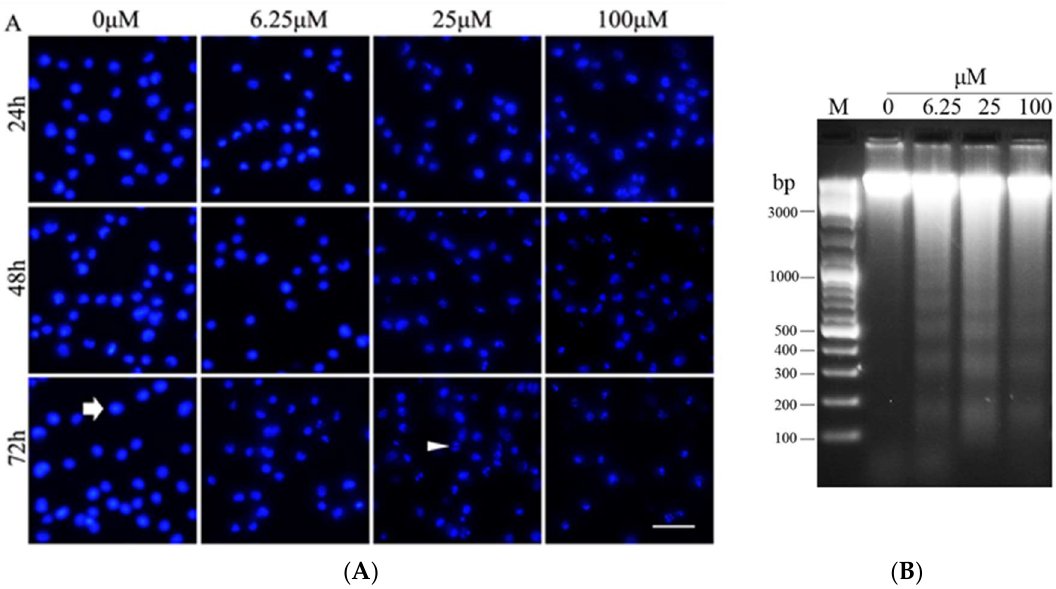
Figure 6. Effects of luteoloside on nuclear morphology and DNA fragmentation in Hela cells. ( A ) The cells treated with or without luteoloside were stained with Hoechst 33342 and observed under a fluorescence microscope. The arrow indicates the cells with round and intact nuclei. The arrowhead indicates the cells with the typical characteristics of apoptosis. Bar = 25 μm; ( B ) Total genomic DNA was isolated from Hela cells treated with or without luteoloside for 48 h. DNA fragmentation was analyzed by agarose gel electrophoresis.